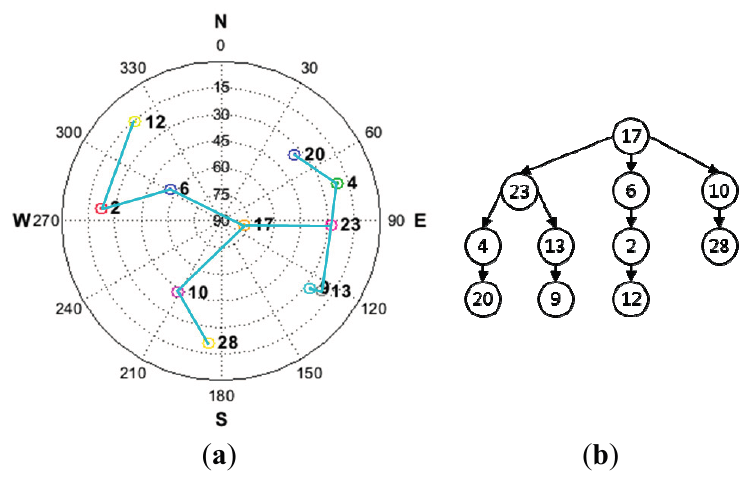
Figure 14. ( a ) Satellite geometry for experiment; ( b ) resulting tree